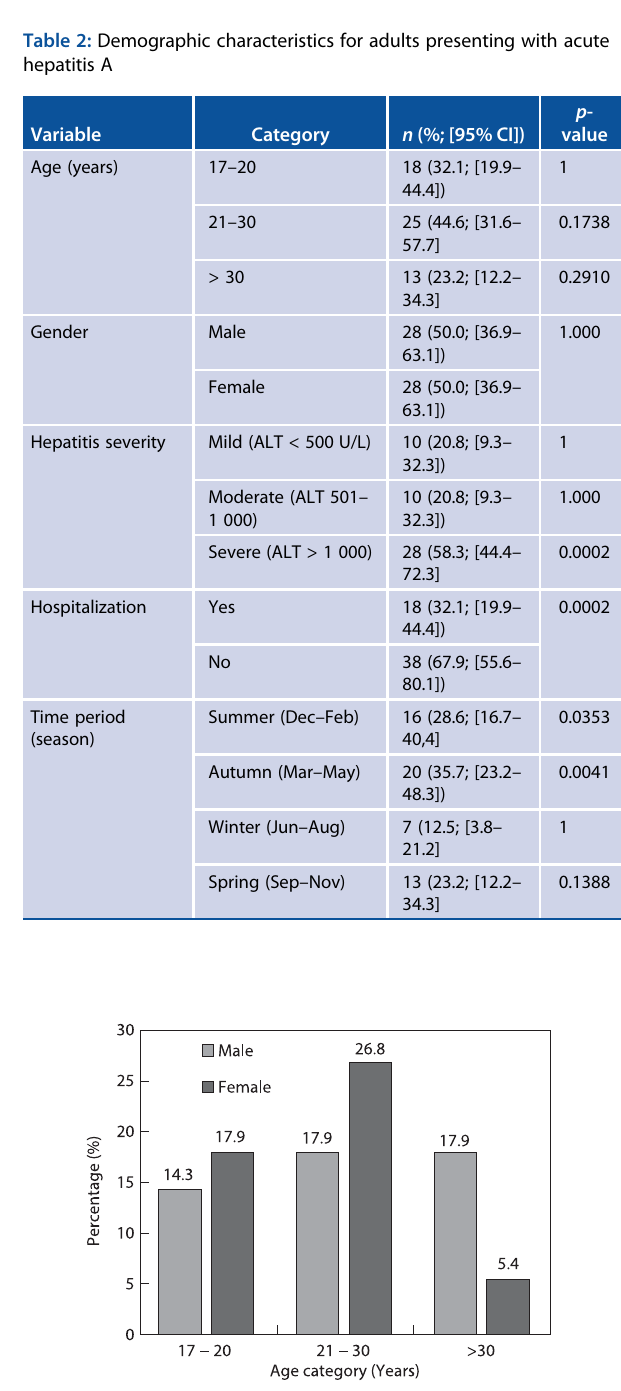
Figure 4: Distribution of adults diagnosed with acute hepatitis A by age group and gender.